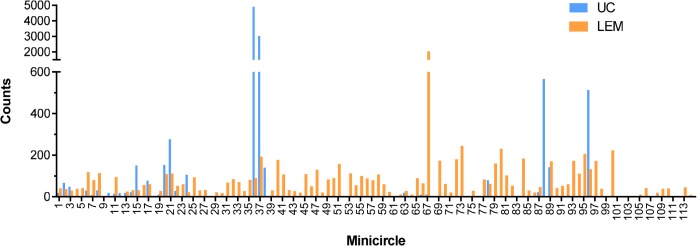
Minicircle sequence classes.The average number of minicircle sequence classes per network was calculated from the number of PacBio CCS reads that assembled to specific minicircles (see Table 2). These values are plotted for both strains as number of minicircles of a specific sequence class/network (assuming 10,000 minicircles per network) versus the mc number (see Table 2).